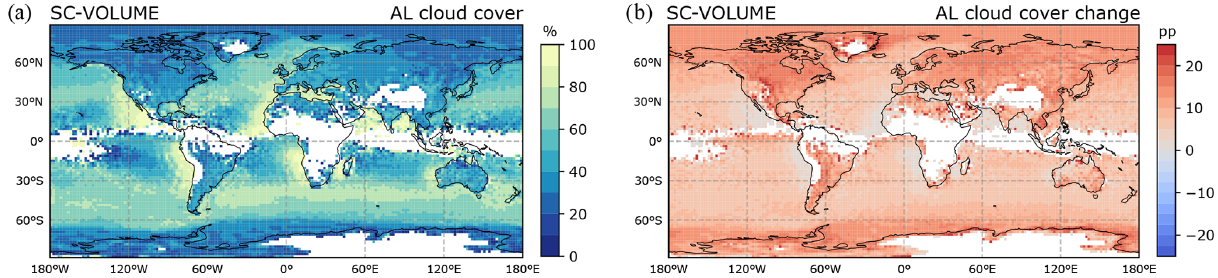
Figure 8. Mean (a) cloud cover and (b) cloud cover change in the ambiguous layer with SC-VOLUME, conditionally sampling cases in which the ambiguous layer contained a cloud. Table 3. Global and regional averages of mean ambiguous layer cloud cover (clc kinv ) and its increase in SC-VOLUME, conditionally sampling cases in which the ambiguous layer contained a